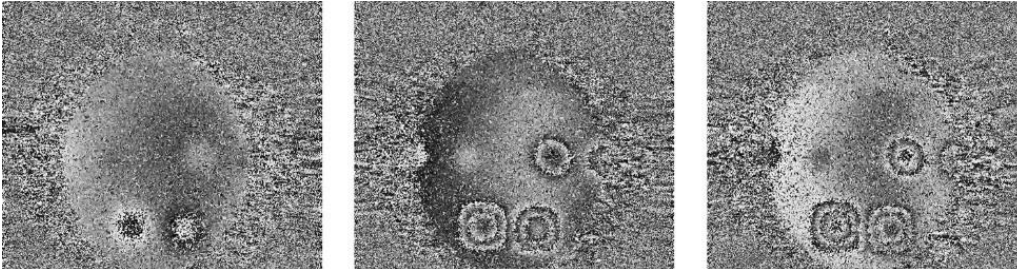
Figure 9. Results of an application of Michelson-based SPS-DS system during dynamic loading.